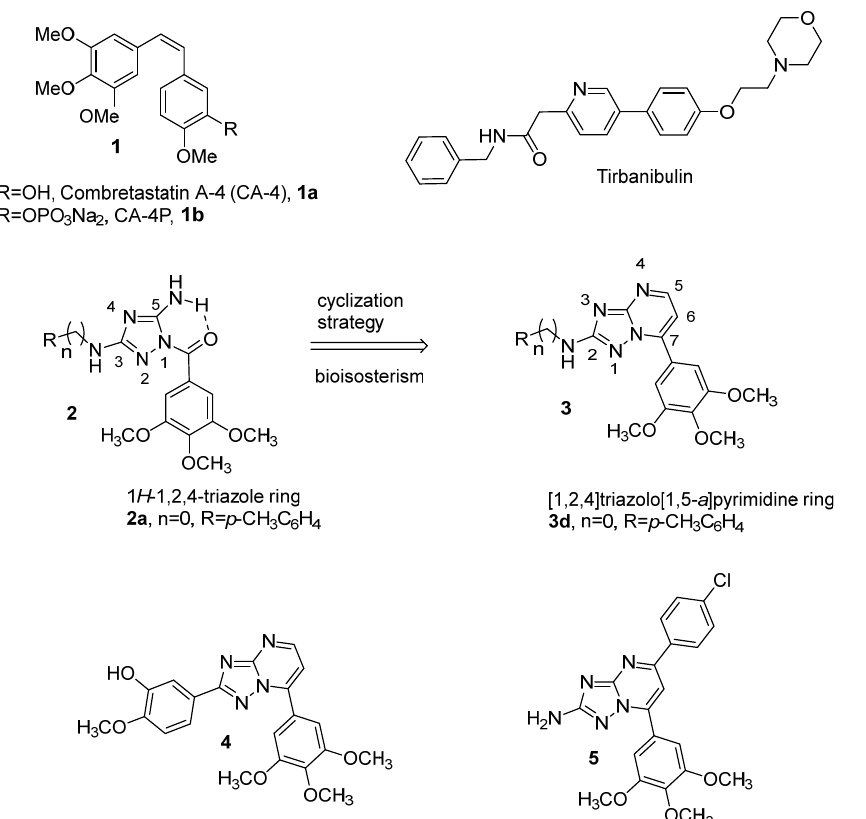
Figure 1. Structures of CA-4 ( 1a ), CA-4P ( 1b ), tirbanibulin, general structure ( 2 ) of 1-(3 ′ ,4 ′ ,5 ′ - trimethoxybenzoyl)-5-amino-1,2,4-triazoles and [1,2,4]triazolo[1,5- a ]pyrimidines reported in this manuscript ( 3 ) and reported in the literature ( 4 and 5 ).